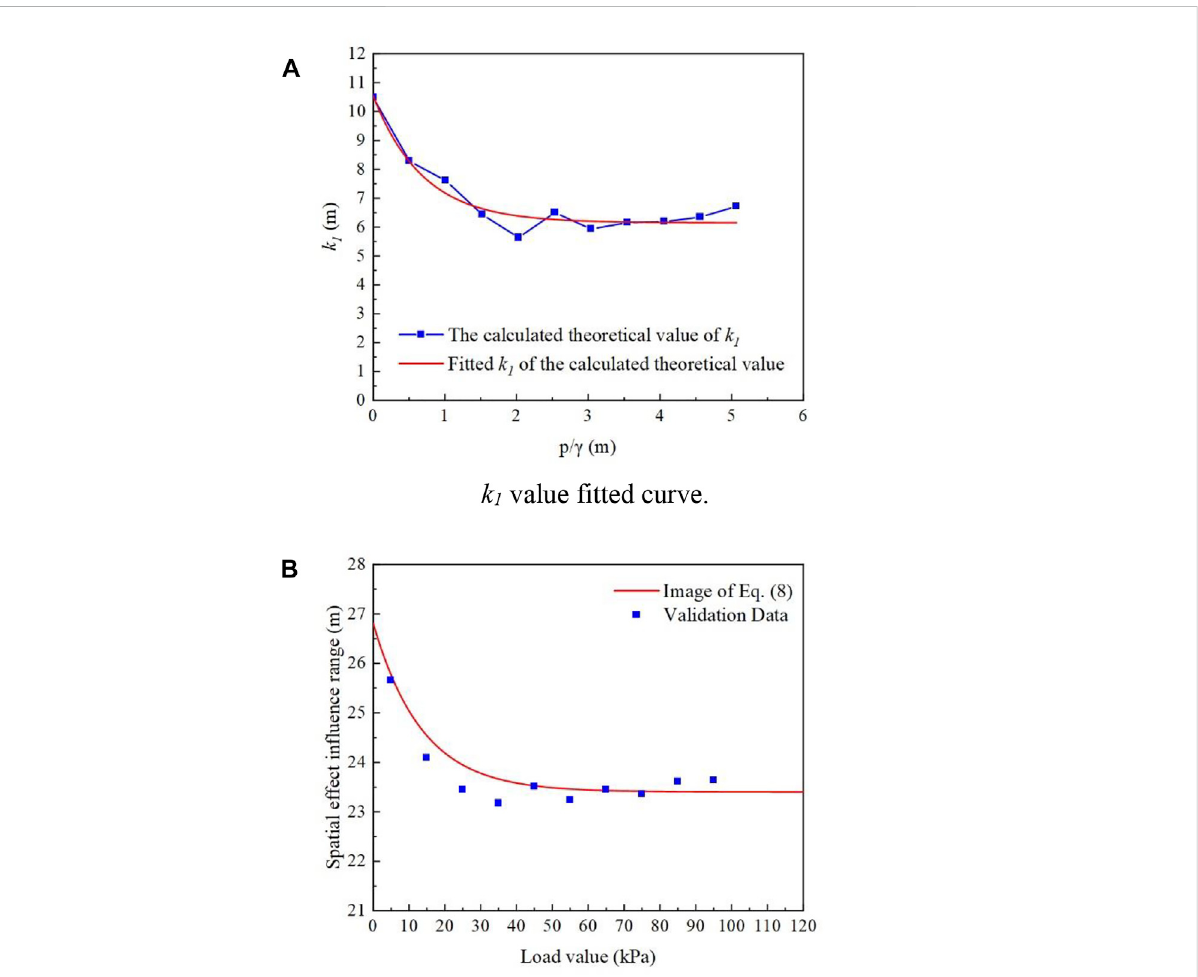
FIGURE 7 Symmetric case fi ttedresultsandvalidationdata. (A) k 1 value fi ttedcurve. (B) Equationandvalidationdataofthein fl uencerangeofspatialeffect considering symmetric load